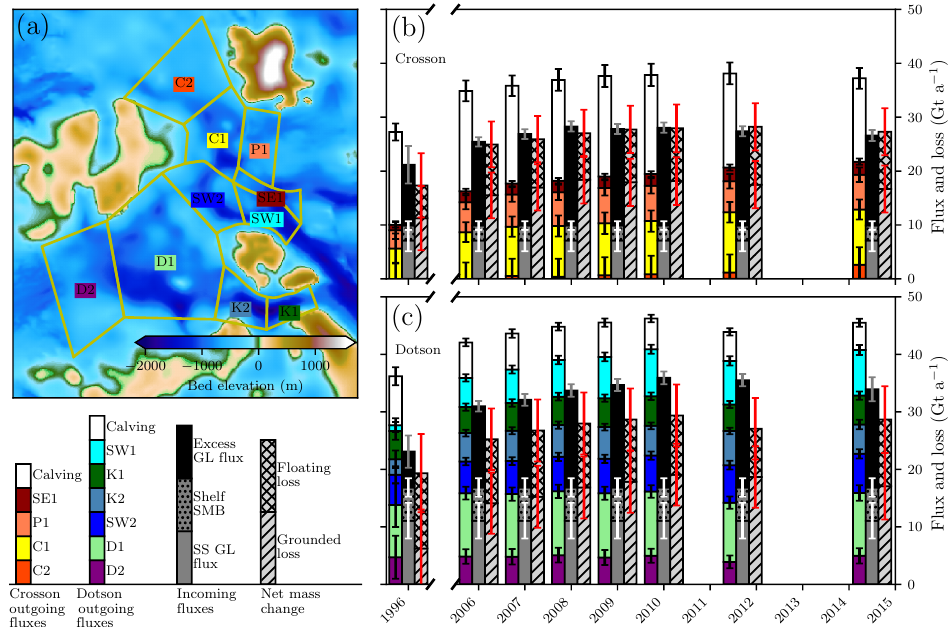
Figure 3. Flux and melt changes over Crosson and Dotson. (a) Areas used for flux divergence calculations, outlined in yellow, plotted over bathymetry from Millan et al. (2017). (b) and (c) Flux and melt over Crosson and Dotson, respectively. Stacked, colored bars show melt over each of the polygons from panel (a) while white bars on top show calving flux; these bars sum to the total outgoing flux. Solid gray bars show the steady-state (SS) grounding-line (GL) flux (calculated from catchment-wide SMB), the dotted gray bars show the SMB over the shelves, and the solid black bar indicates the additional flux crossing the grounding line each year due to dynamic imbalance; these bars total to all incoming flux to the shelves. Light gray slashed bars indicate the loss of grounded ice (equal to the black bars in the previous column) and the cross-hatched light gray region shows the additional loss of floating ice (equal to the difference between the first two columns); these total to the annual mass loss